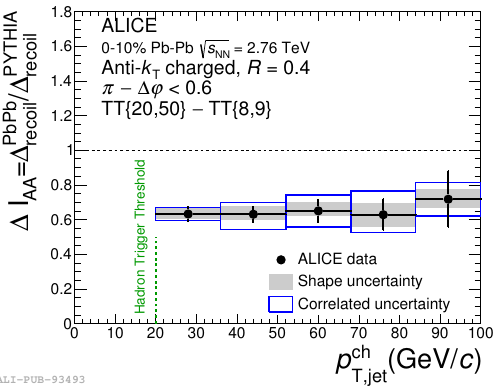
Figure 2. Ratio of ∆ recoil spectra obtained from the 0–10% centrality bin of Pb–Pb collisions at √ s NN = 2.76TeV and from the PYTHIA 6 Perugia 2010 simulation of pp collisions at Systematic uncertainties in the data are shown by boxes. Taken from